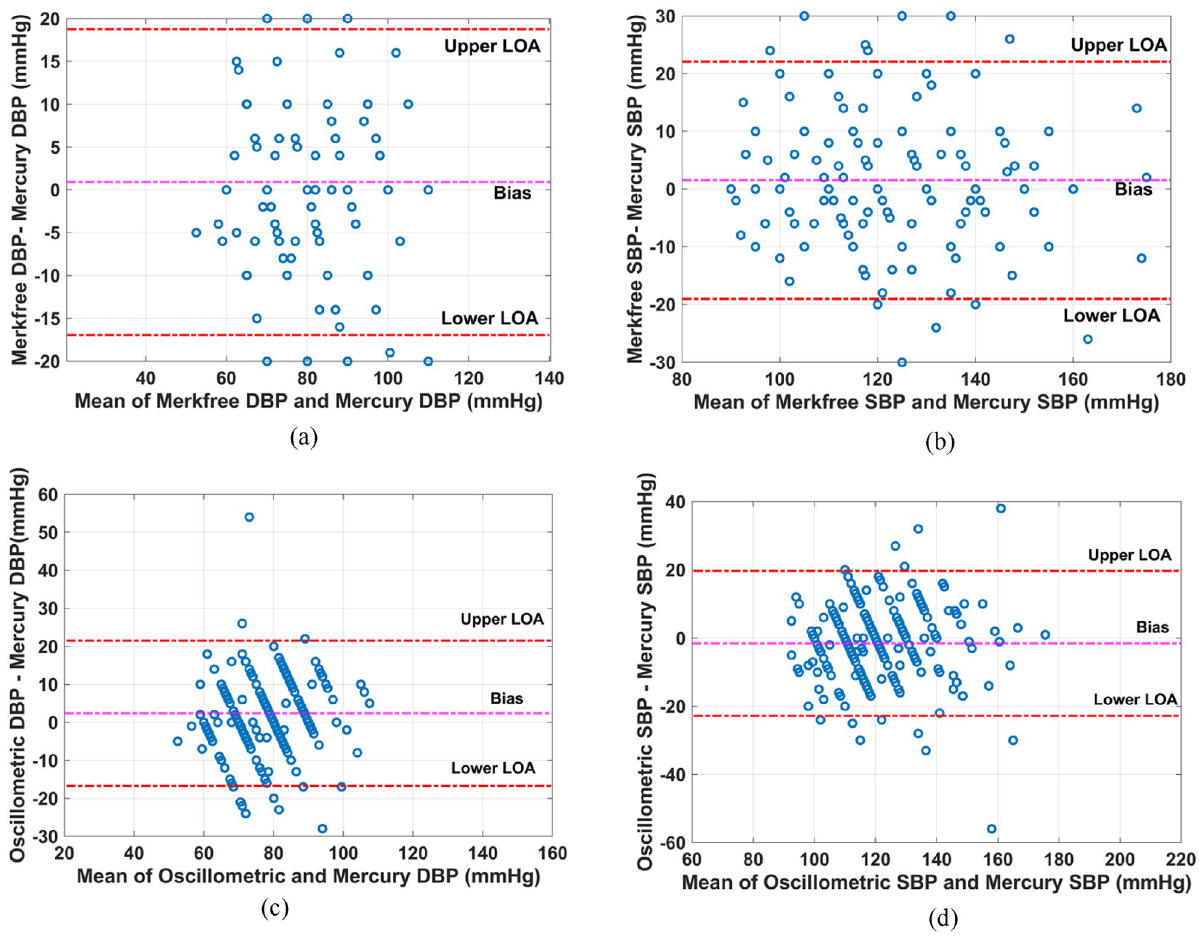
Figure 6. Bland Altman’s plot ( a ) DBP readings of Merkfree versus Mercury, ( b ) SBP readings of Merkfree versus Mercury, ( c ) DBP readings of Oscillometric versus Mercury, ( d ) SBP readings of Oscillometric versus